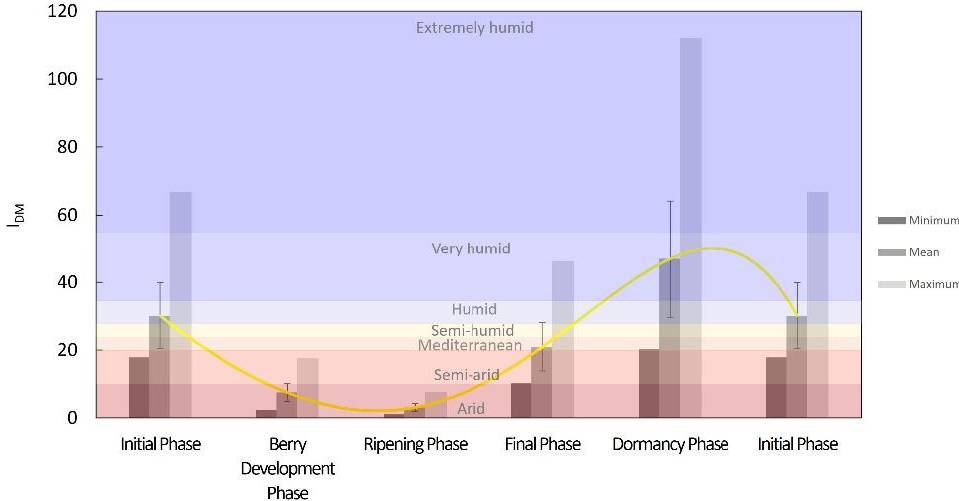
Figure 3. Mean, maximum, minimum I DM , and standard deviation for the vine phases in Extremadura (1989 – 2020).